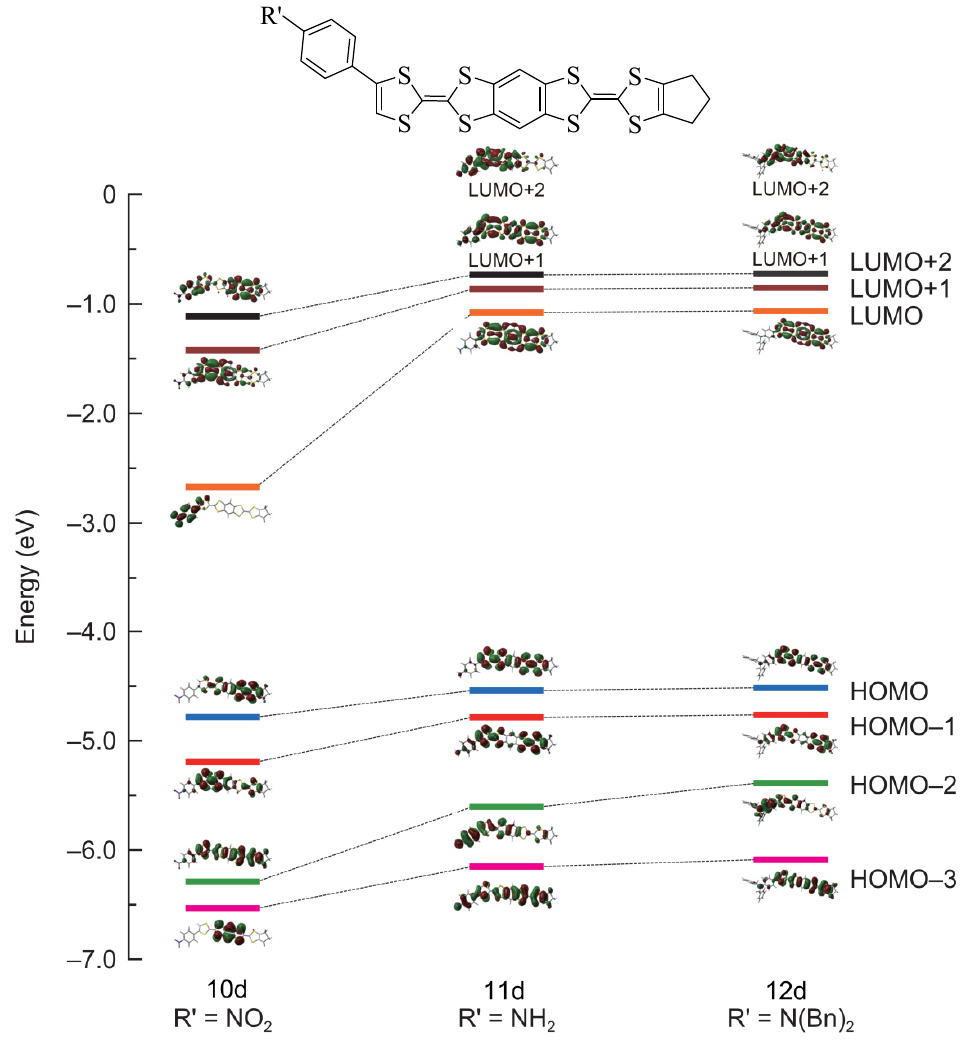
Figure 3. Levels of HOMO and LOMO of compounds 10d , 11d and 12d